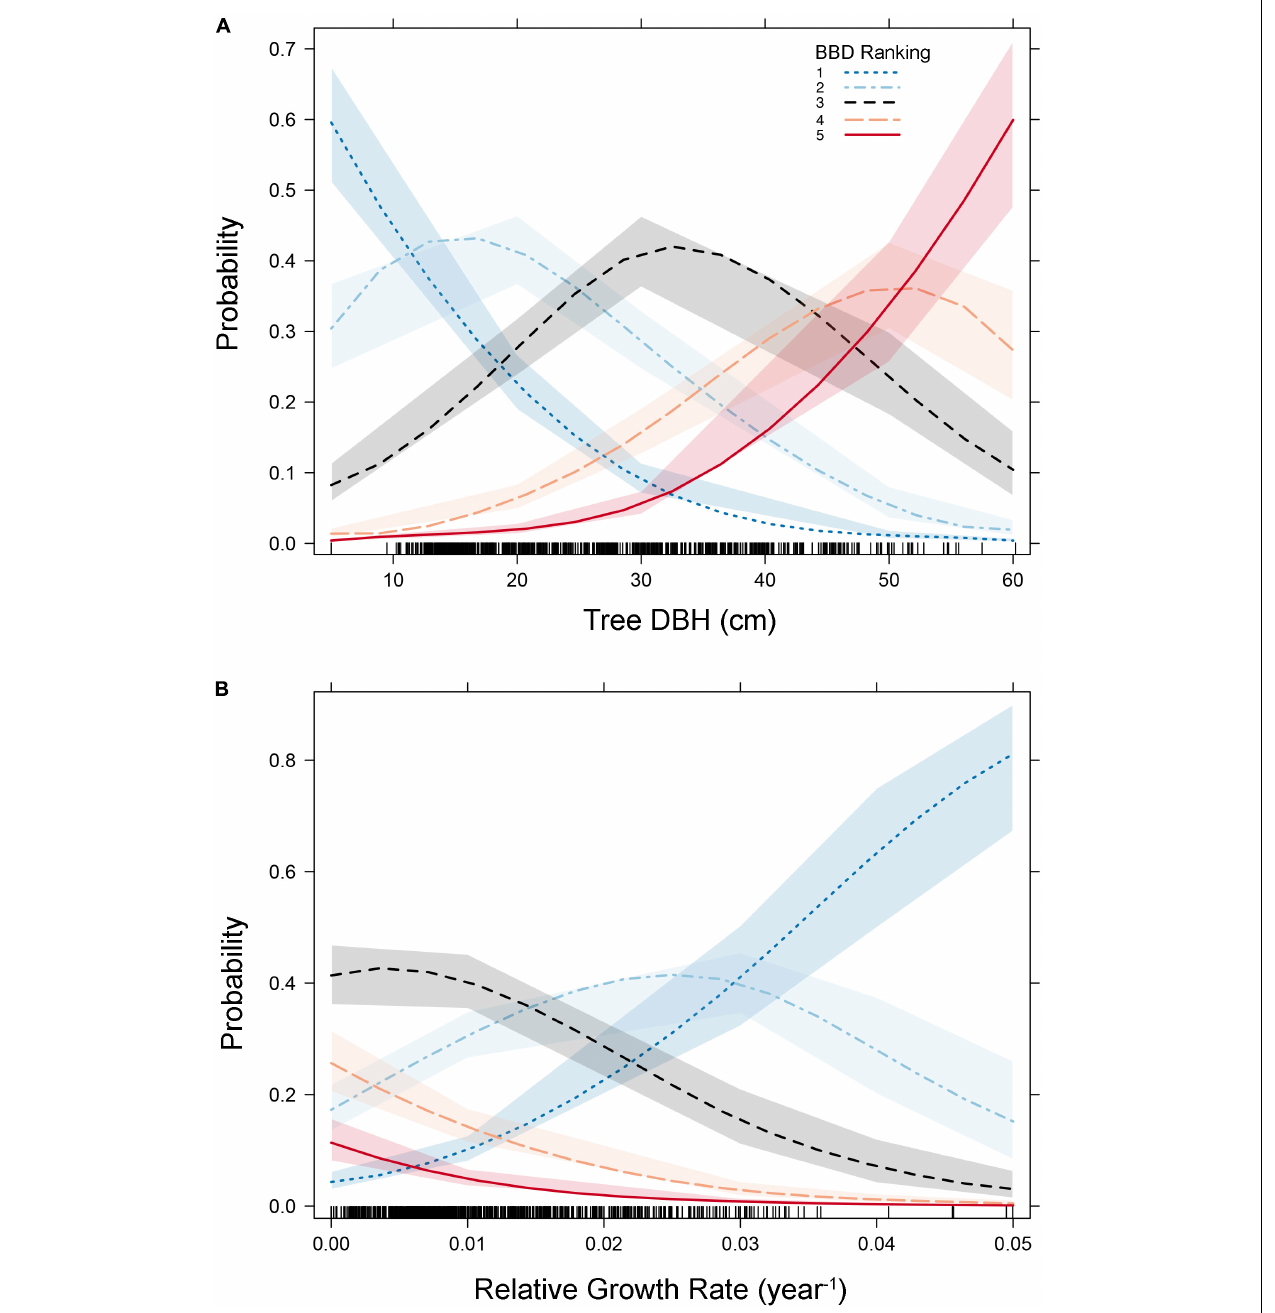
FIGURE 2 | Plots predicting the probability of beech bark disease (BBD) symptom rankings as a function of tree- diameter at breast height (DBH) [Panel (A) ] and relative growth rate [Panel (B) ]. Variables included in our ordinal logistic regression model are presented here (as per Table 1 and Supplementary Table 1 ). Shaded areas represent the 95% confidence intervals surrounding predicted probabilities, and the rug plots along the x-axis show the distribution of the data points (i.e., trees) along the values of the independent axis.